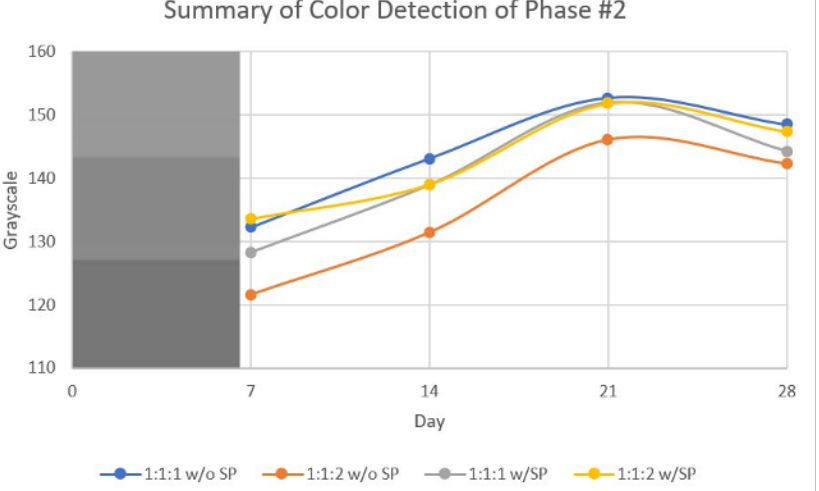
Figure 5. Average Color Detection of each Design